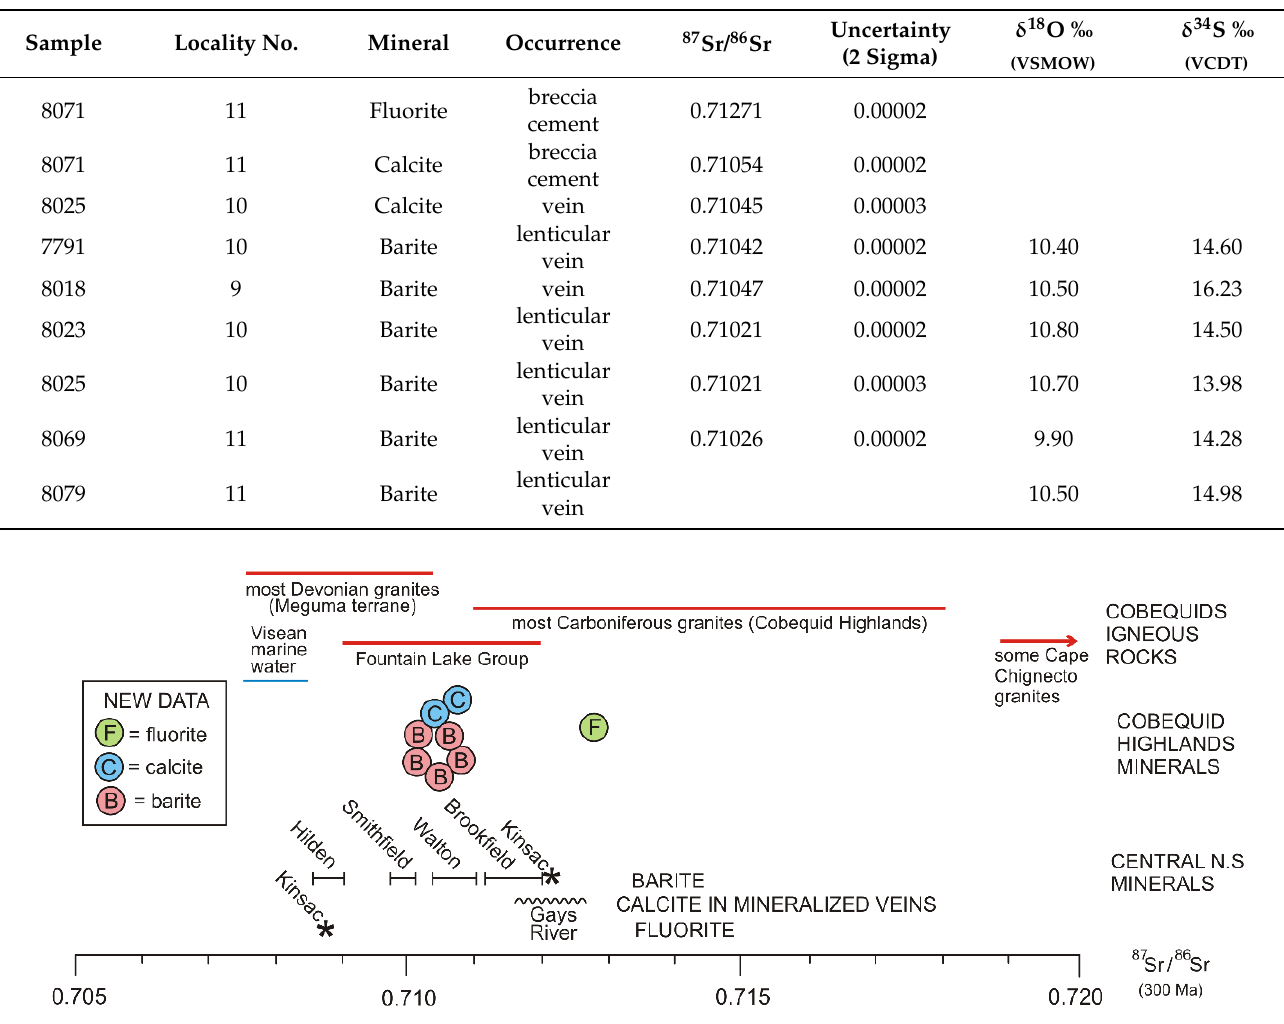
Table 3. Strontium, oxygen and sulfur isotope analyses of fluorite, calcite and barite. Sample